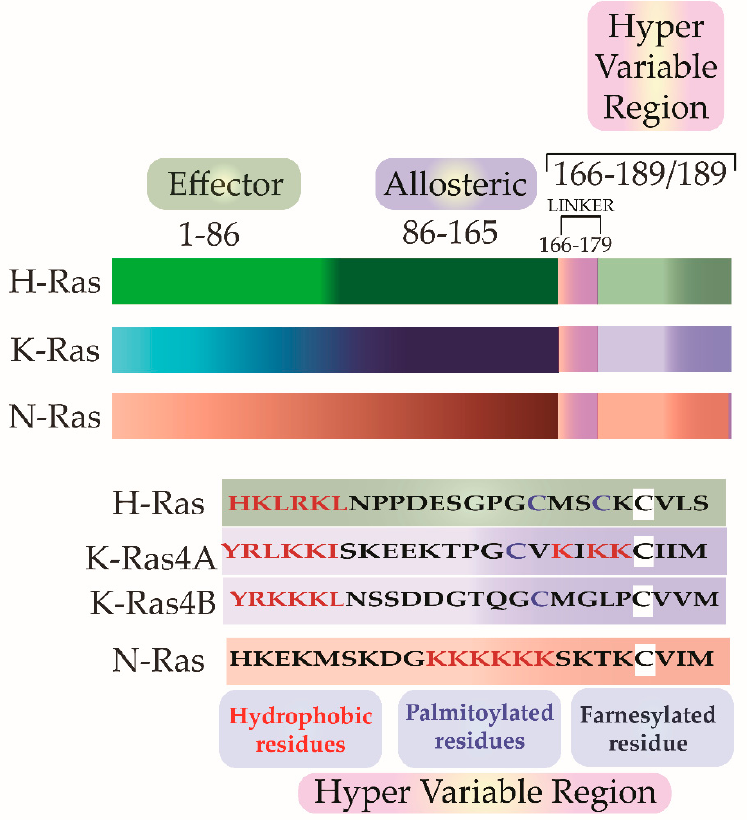
Figure 2. The isoforms share sequence similarities in their G-Domain (1–165 aa). This is followed by a Hyper Variable Region (HVR) (166–188/189), which differs in all three isoforms in sequence as well as in the post-translational modifications. In addition to farnesylation, a post-translational modification that all the three isoforms undergo, H-Ras and N-Ras further undergo dual and single palmitoylation, respectively. K-Ras undergo the addition of a stretch of polylysine residues.